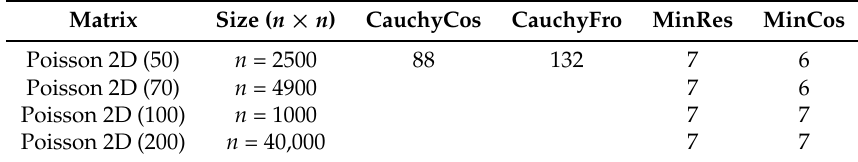
Table 2. Number of iterations required for all considered methods when (cid:101) = 0.01. Matrix Size ( n × n